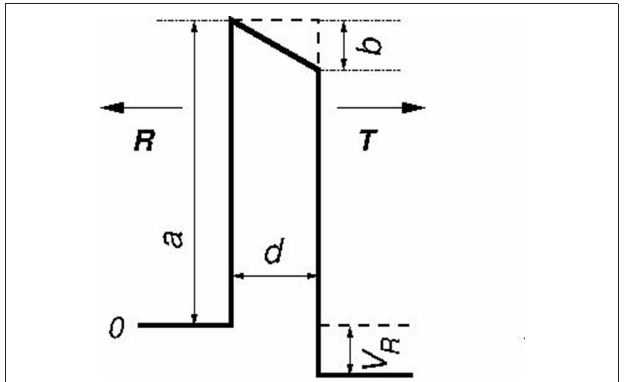
FIGURE 2 | Regions of asymptotic representations z 0 , z 1 0 ( S 0 ) and → z 0 , z 1 ( S ) with separating line L 0, . Three balls indicate → ±∞ ∞ ∞ S 0 , µ ν 1 characteristic points P 1,1 : = { = = } ∈ S S P 2,0 : µ µ 2, ν 1 2, ν 0 and P 2,1 : = { = = } ∈ = { = = } ∈ ∞ ∞